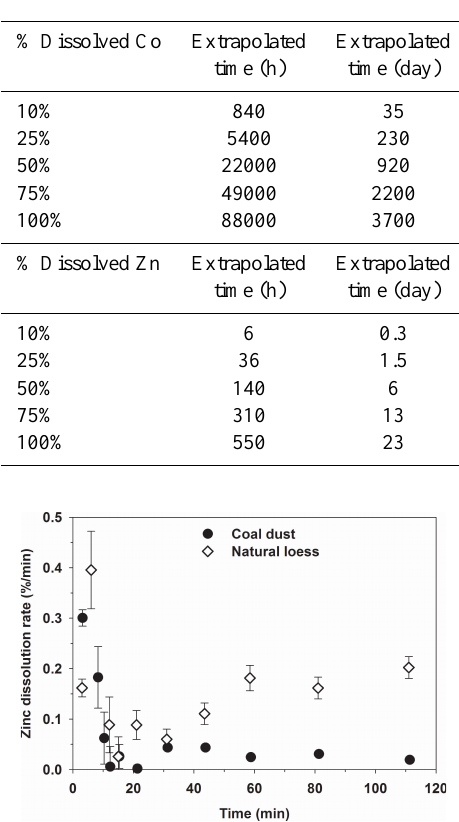
Fig. 5. Dissolution rates of zinc (%/min) for anthropogenic and natural dust as function of time.